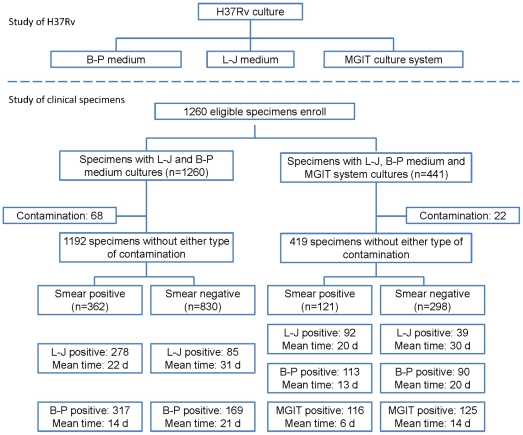
Flow chart.This study evaluated the biphasic medium (B–P medium) for the recovery of H37Rv and mycobacteria in clinical sputum specimens. A total of 1260 sputum specimens were decontaminated and cultured in the L-J slant and biphasic medium. Among them, the MGIT culture system was also used in 441 decontaminated specimens in addition to the presence of the L-J slant and biphasic medium.